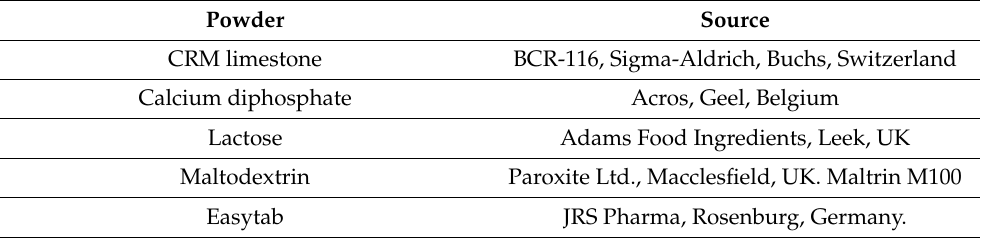
Table 1. Summary of the test materials used in this